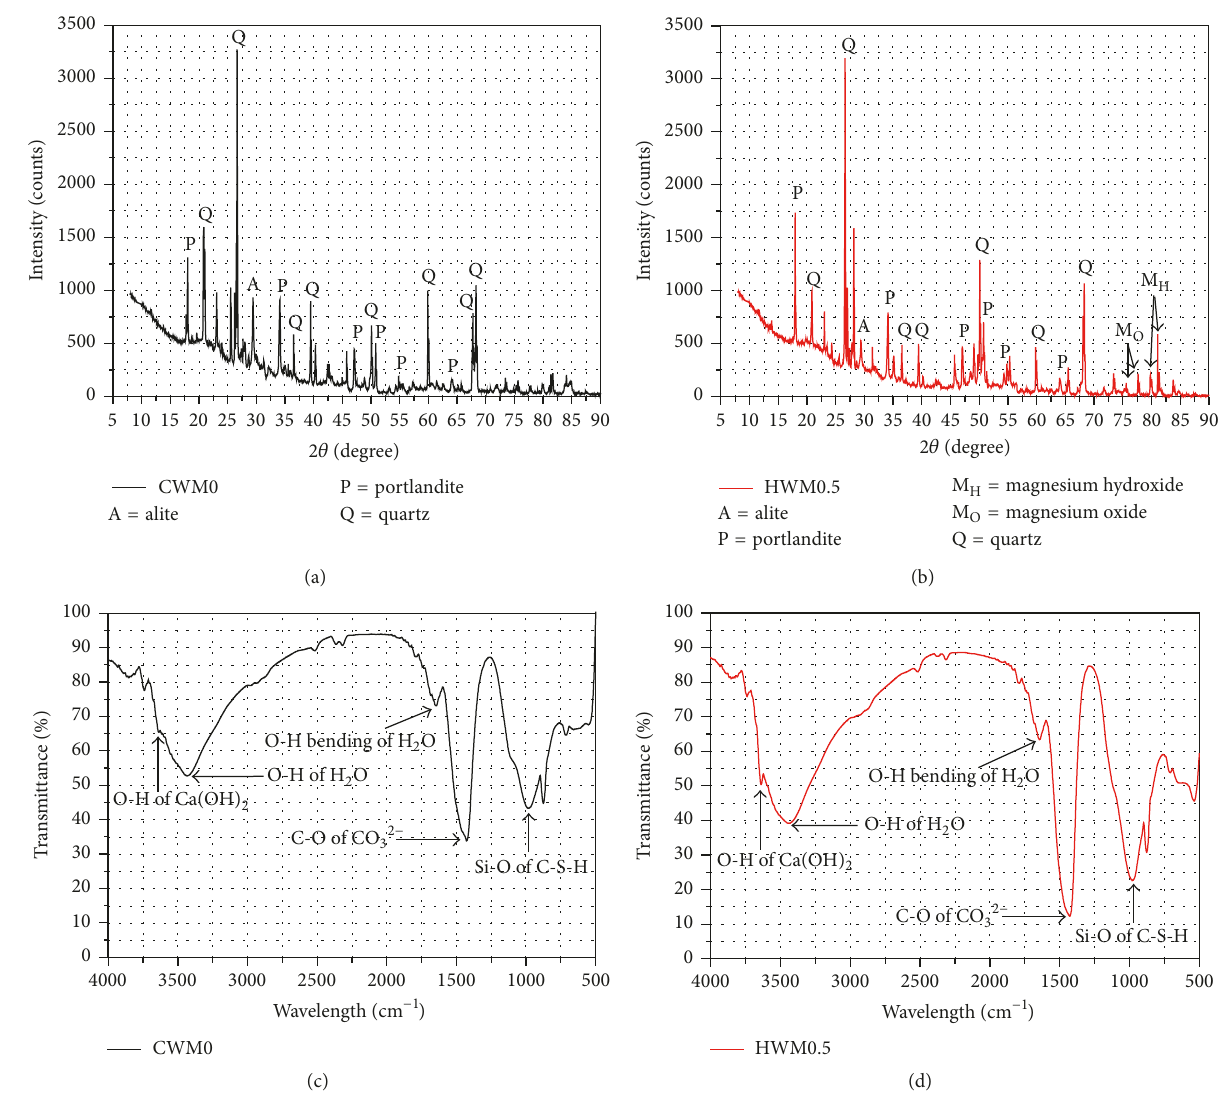
Figure 7: (a) XRD pattern for CWM0 after 28 days of hydration; (b) XRD pattern for HWM0.5 after 28 days of hydration; (c) FTIR transmittance spectrum for CWM0 after 28 days of hydration; (d) FTIR transmittance spectrum for HWM0.5 after 28 days of